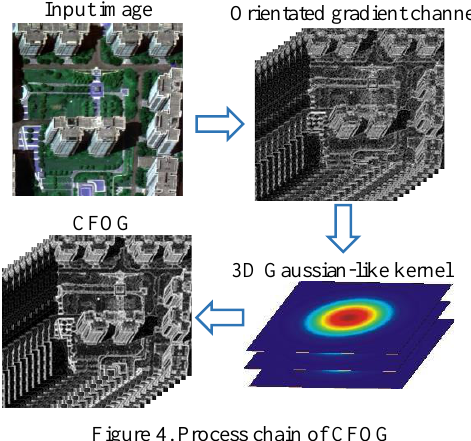
Figure 4. Process chain of CFOG